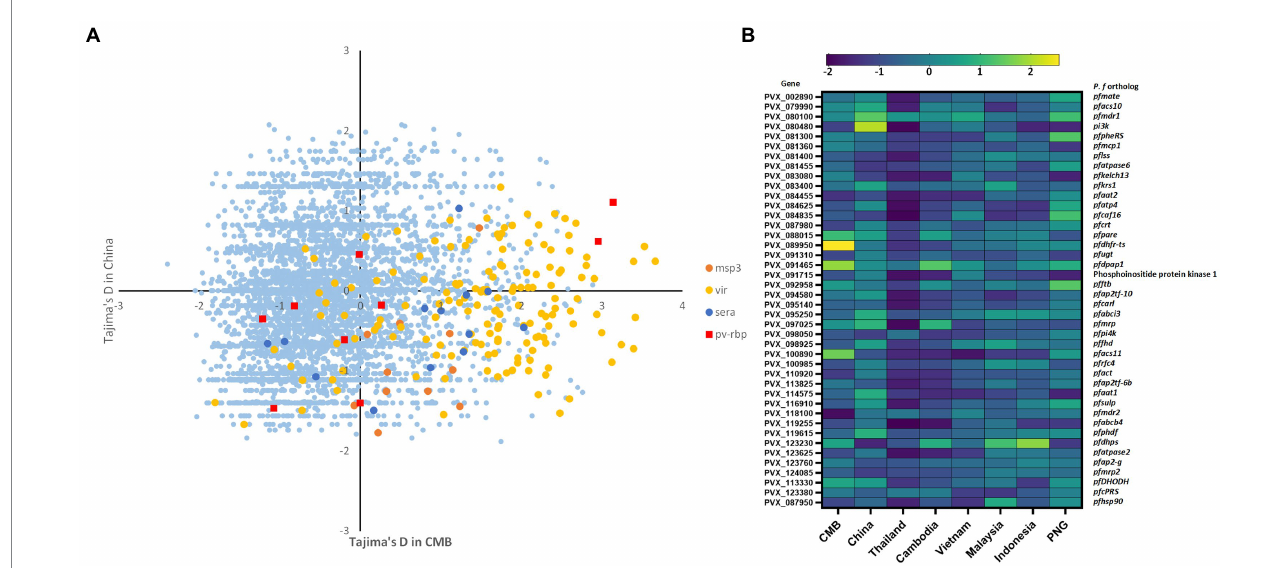
FIGURE 3 Balanced selection (Tajima’s D-value) of 5,249 genes in inland and border populations. (A) Balanced selection (Tajima’s D-value) of all genes in both populations. We selected some immune-related genes such as vir , msp., and rbp to evaluate the differences in environmental stress between China inland and CMB samples. Tajima’s D-values of China inland samples were mostly negative with a mean of − 0.12, a bit higher than CMB. However, there was a clear difference in vir gene families, consistent with the difference in malaria transmission between the two places in the 2010s. (B) A balanced selection of 42 orthologs of P. falciparum drug-resistance genes summarizing the difference between inland and reference populations. The Southeast Asian population exhibited higher overall pressure levels than Pacific island populations in Tajima’s D-test but no significant difference in pvcrt and pvmdr1 . In antifolate-resistance genes, there are positive balance selective pressures in the Southeast Asian population but negative balance selective in island